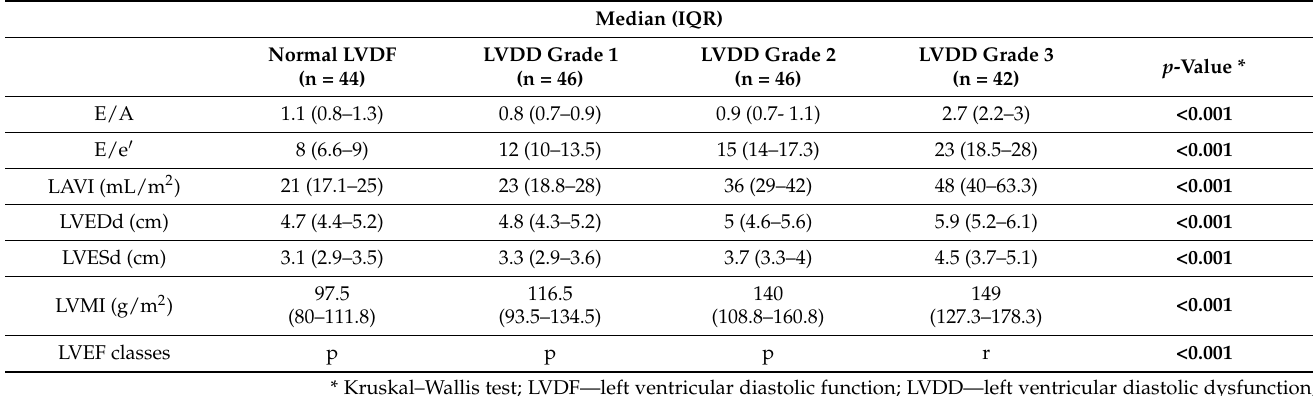
Table 2. Echocardiographic parameters in the study